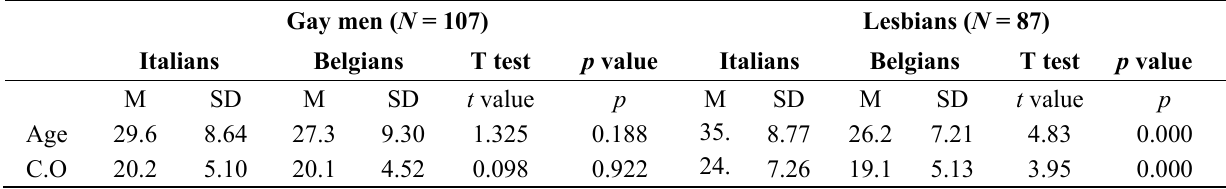
Table 1. Mean and standard deviation of age and age at the time of Coming-Out of each group. Gay men ( N = 107)